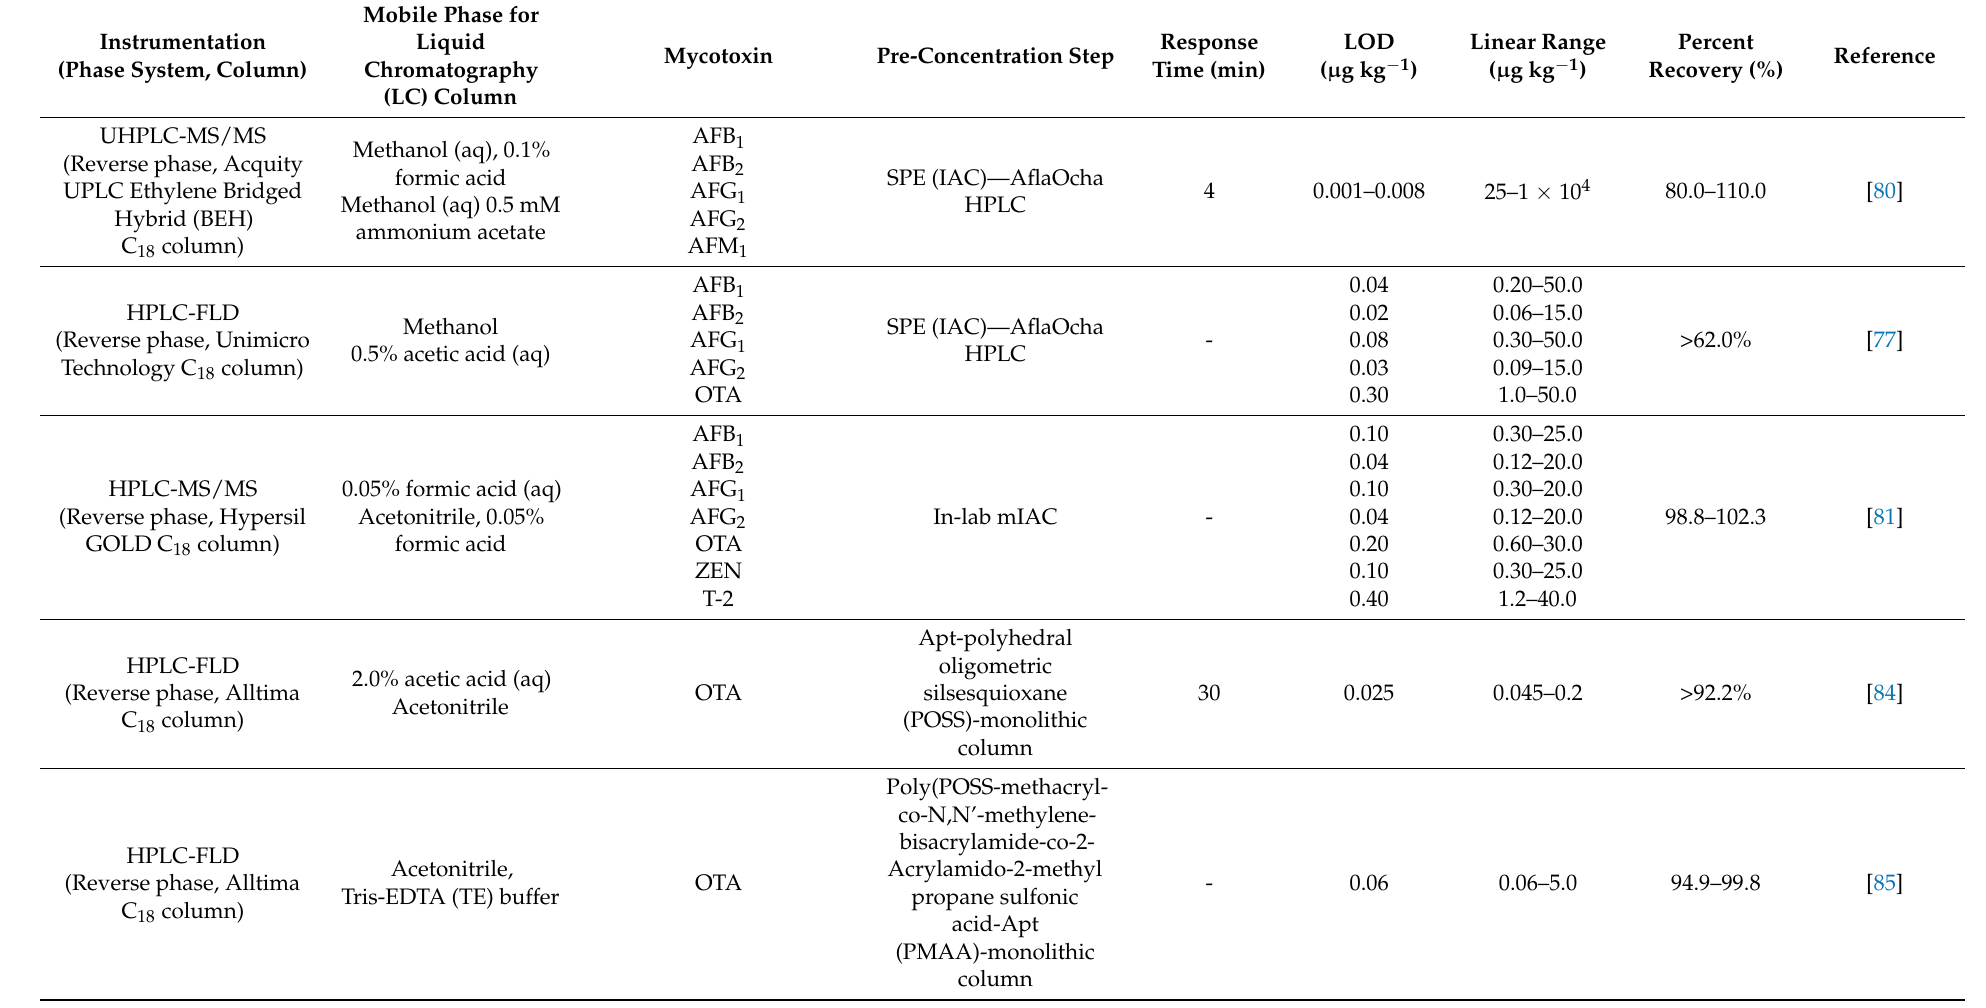
Table 2. Detection of mycotoxins based on different instrumentation systems and sample